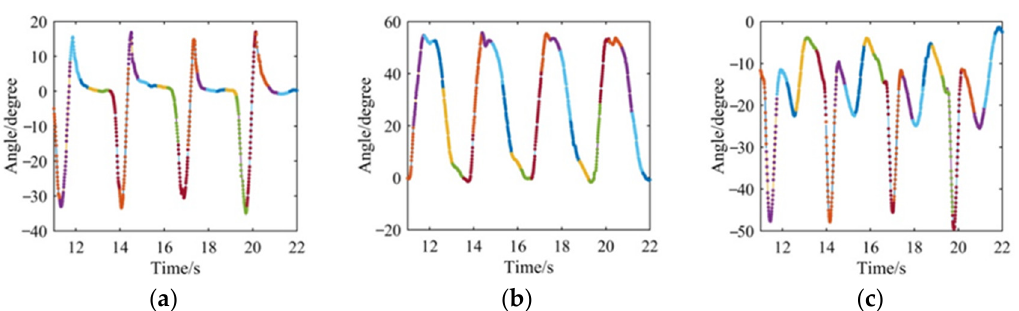
Figure 8. Piecewise curve-fitting results in going upstairs process. ( a ) Angle of hip joint; ( b ) Angle of knee joint; ( c ) Angle of ankle joint.